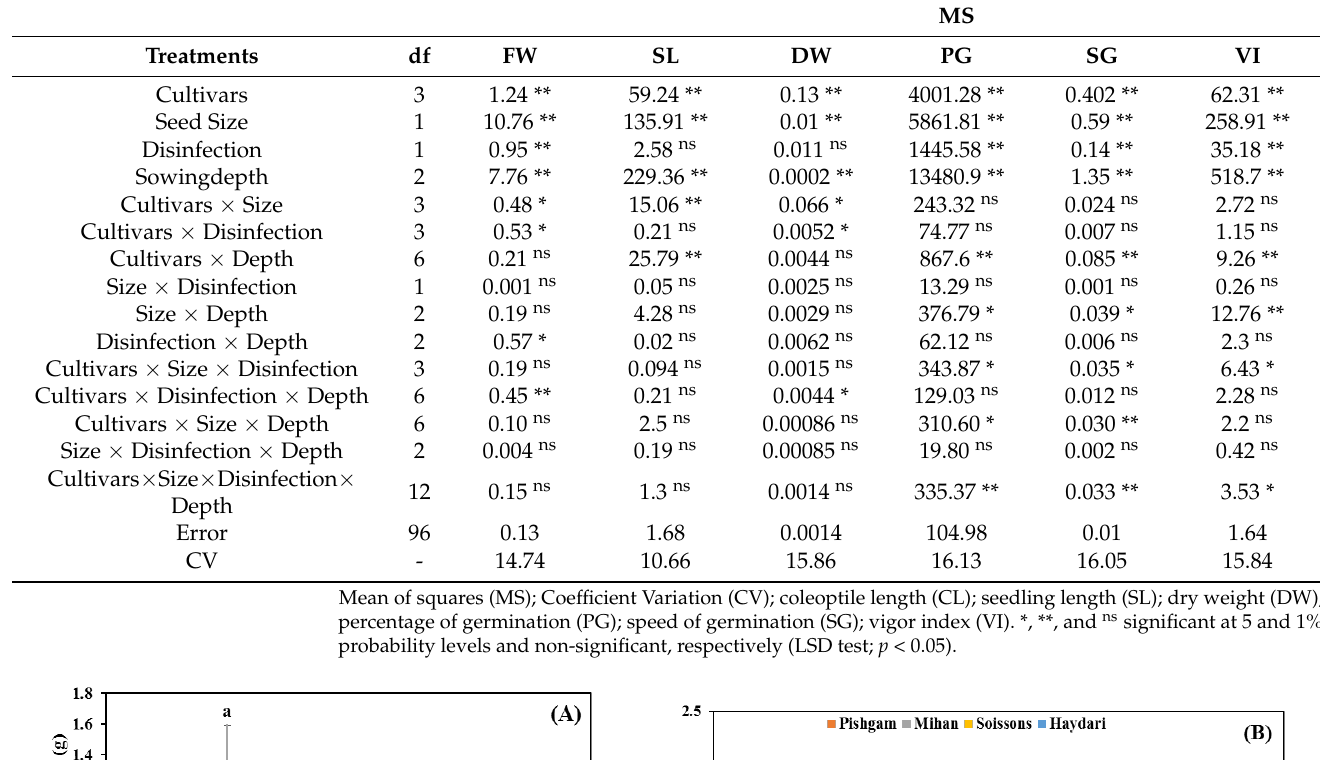
Table 3. Effect of cultivar, seed size, depth sowing, and seed disinfection on wheat germination characteristics.